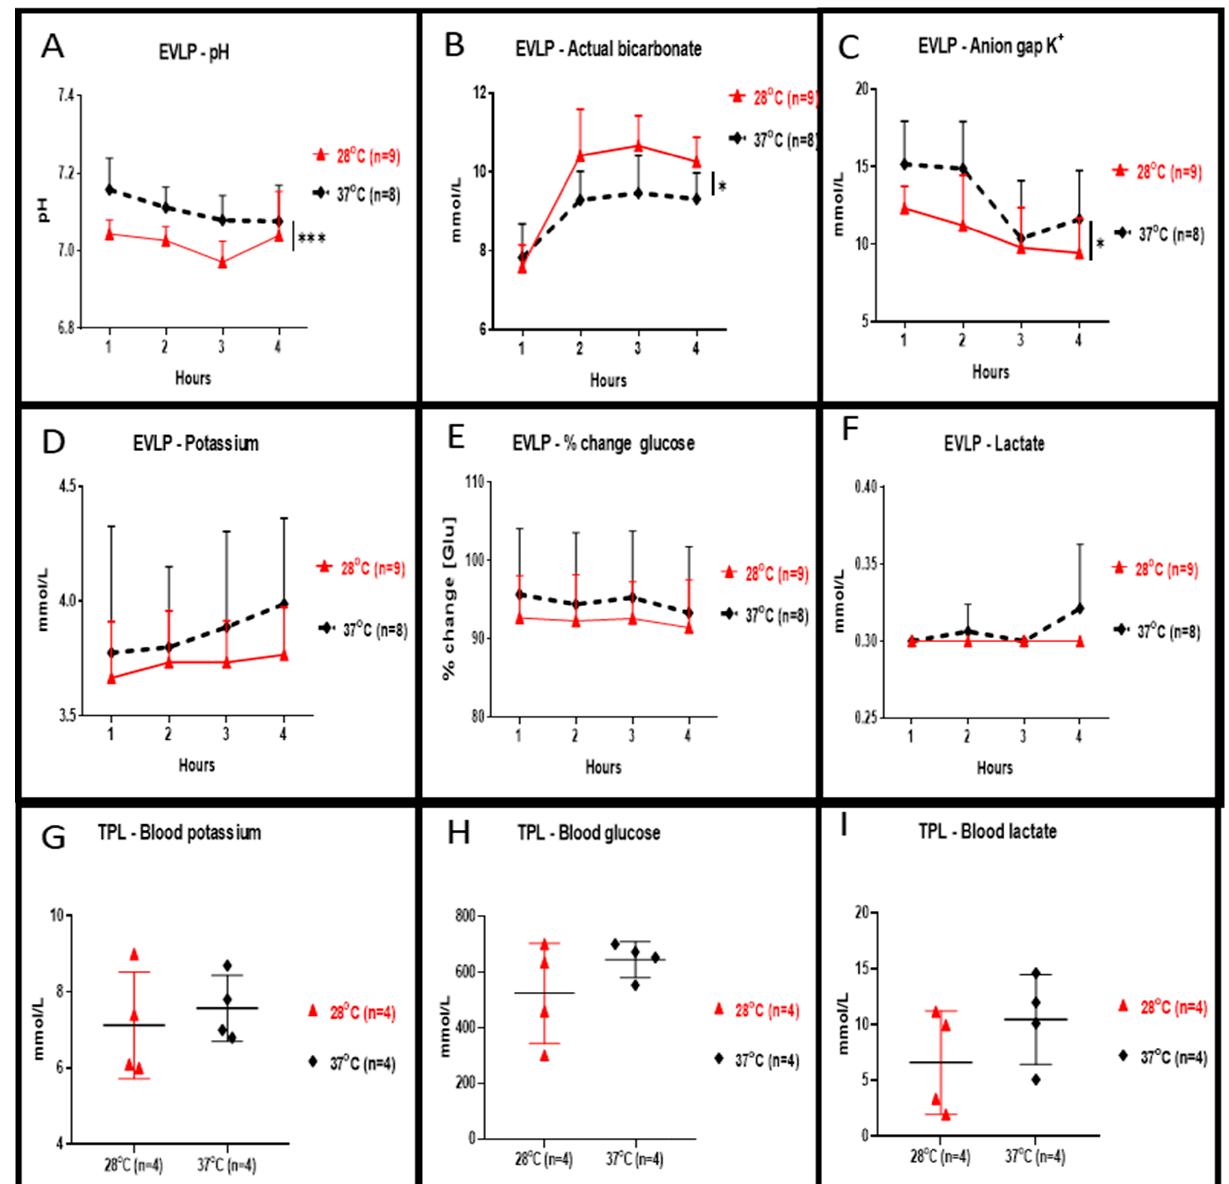
Figure 3. Clinical biochemistry during EVLP and after left lung transplantation. During EVLP done at 28 °C we recorded: ( A ) a significantly lower pH (*** p < 0.001), and ( B ) bicarbonate levels significantly higher (* p < 0.05), and ( C ) significantly lower anion gap K+ values (* p < 0.05) when compared to EVLP done at 37 °C. The potassium concentration of the perfusate ( D ) and in the plasma ( G ) were lower at 28 °C but the concentration was not statistically different when compared to the 37 °C groups. ( E ) The glucose concentration in the 28 °C EVLP perfusate and ( H ) in the plasma of transplanted rats from the 28 °C group was not significantly lower when compared to experiments done at 37 °C. ( F ) In the 28 °C EVLP perfusate and ( I ) in the plasma of transplanted rats of the 28 °C group, the lactate concentration was not significantly lower when compared to experiments done at 37 °C. TPL: transplantation.